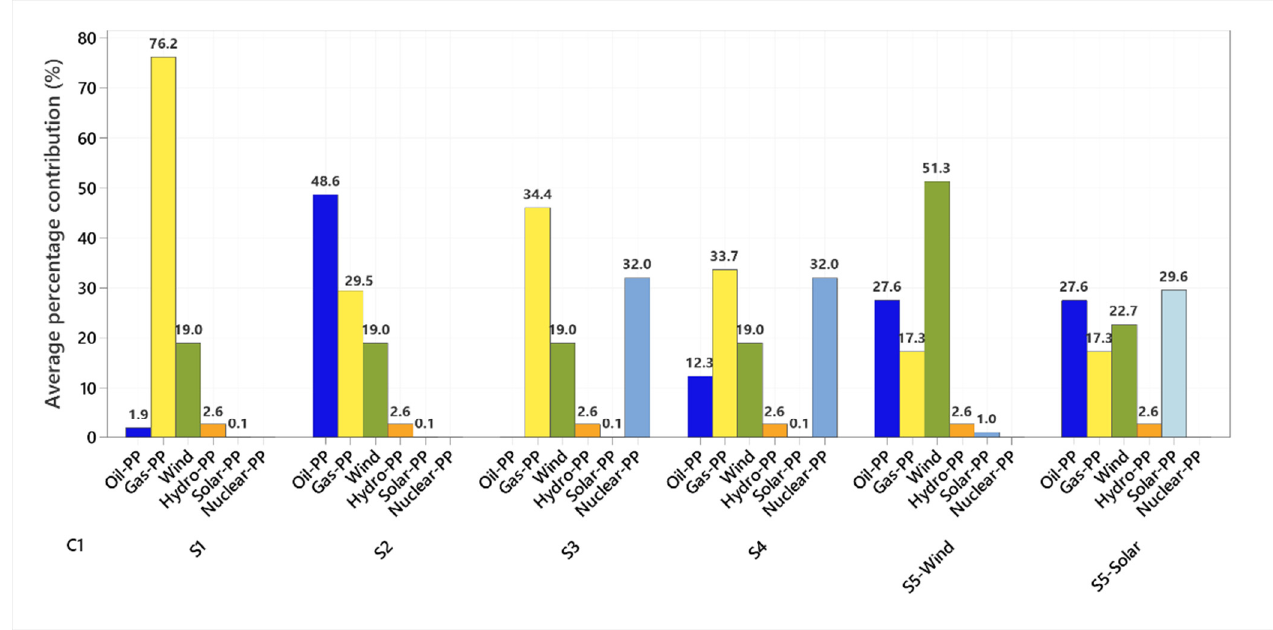
Figure 12. Summarizes the average contribution of each technology in every